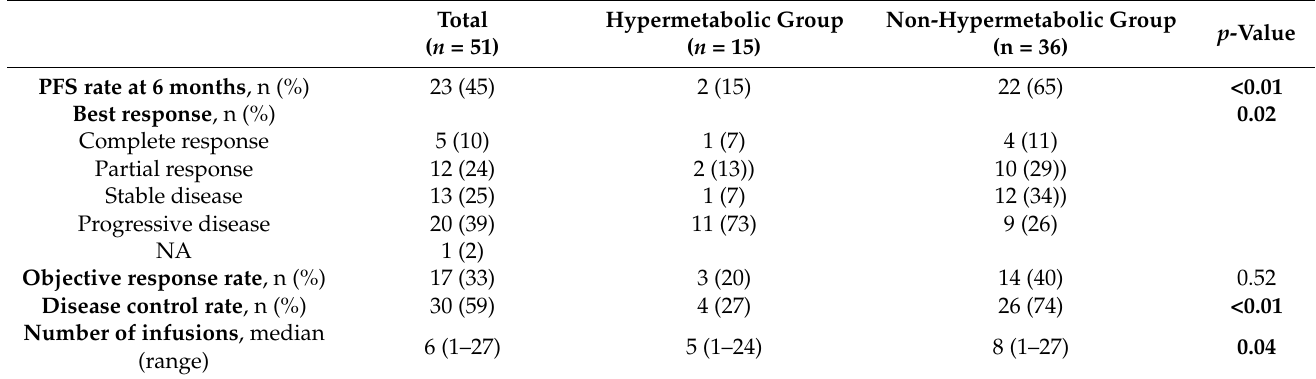
Table 4. Efficacy of